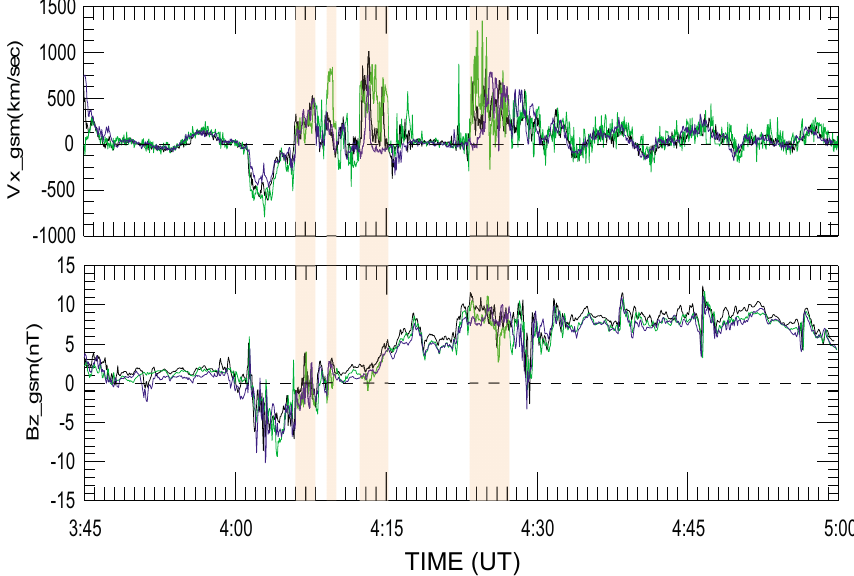
Fig. 9. Intermittent high speed earthward flow bursts exceeding velocities of the order of 700km/s with northward magnetic field.